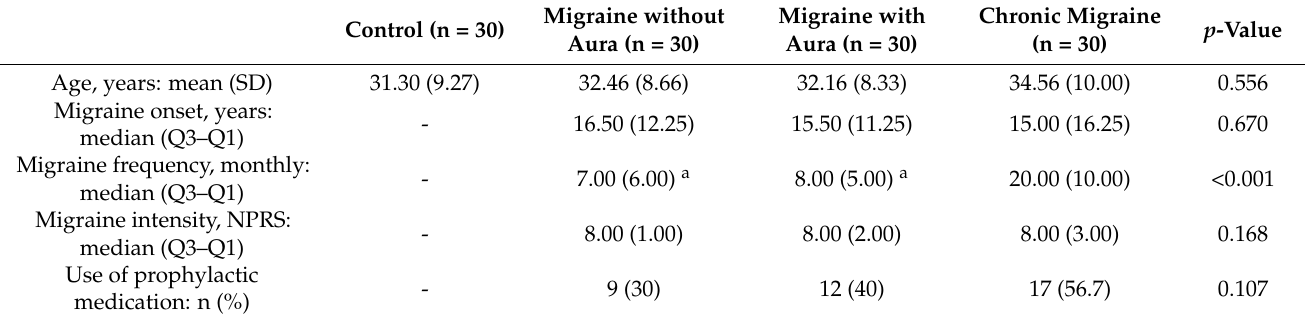
Table 1. Sample demographics and headache